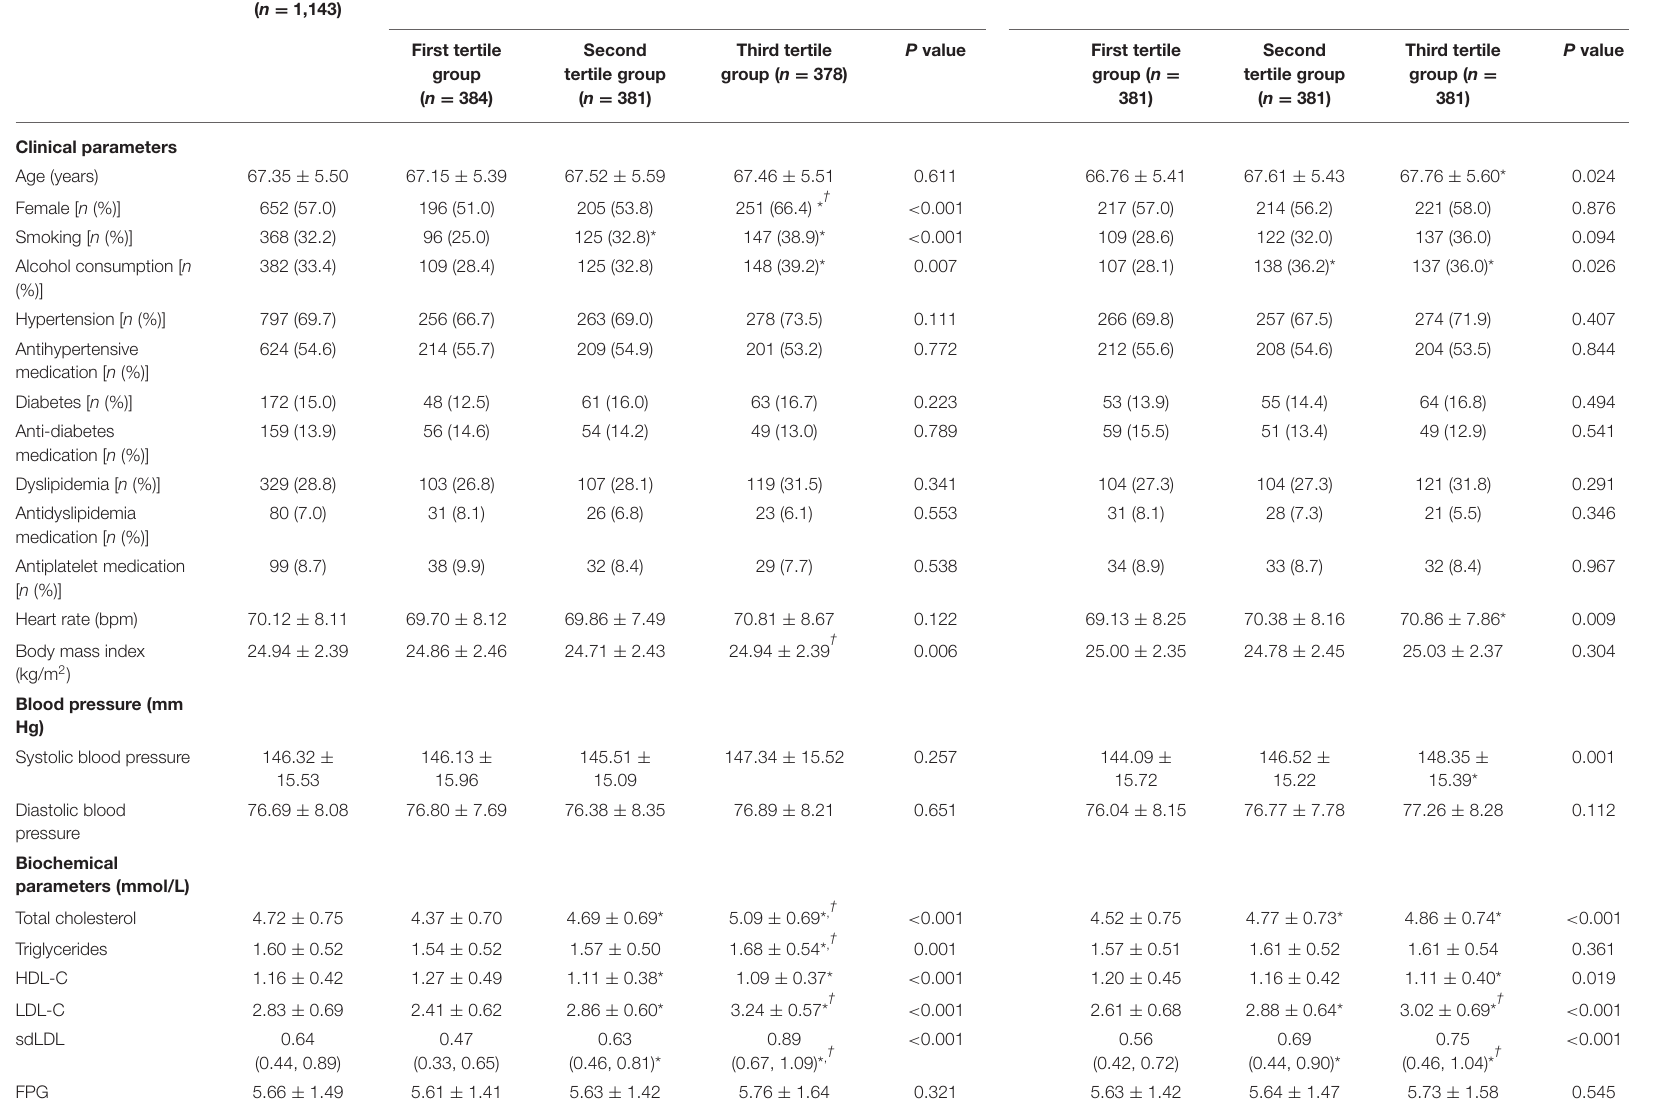
TABLE 1 | Participant demographic and baseline clinical characteristics. All Grouped by tertile of visit-to-visit mean ( n = 1,143)